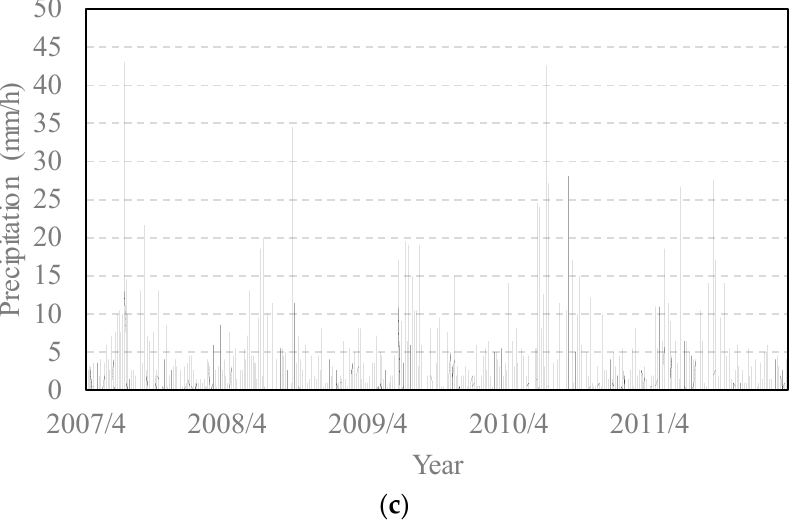
Figure 2. Time variation of ( a ) air temperature, ( b ) wind speed, and ( c ) precipitation of weather conditions, from JFY 2007 to 2011, at Hikone (observation point).